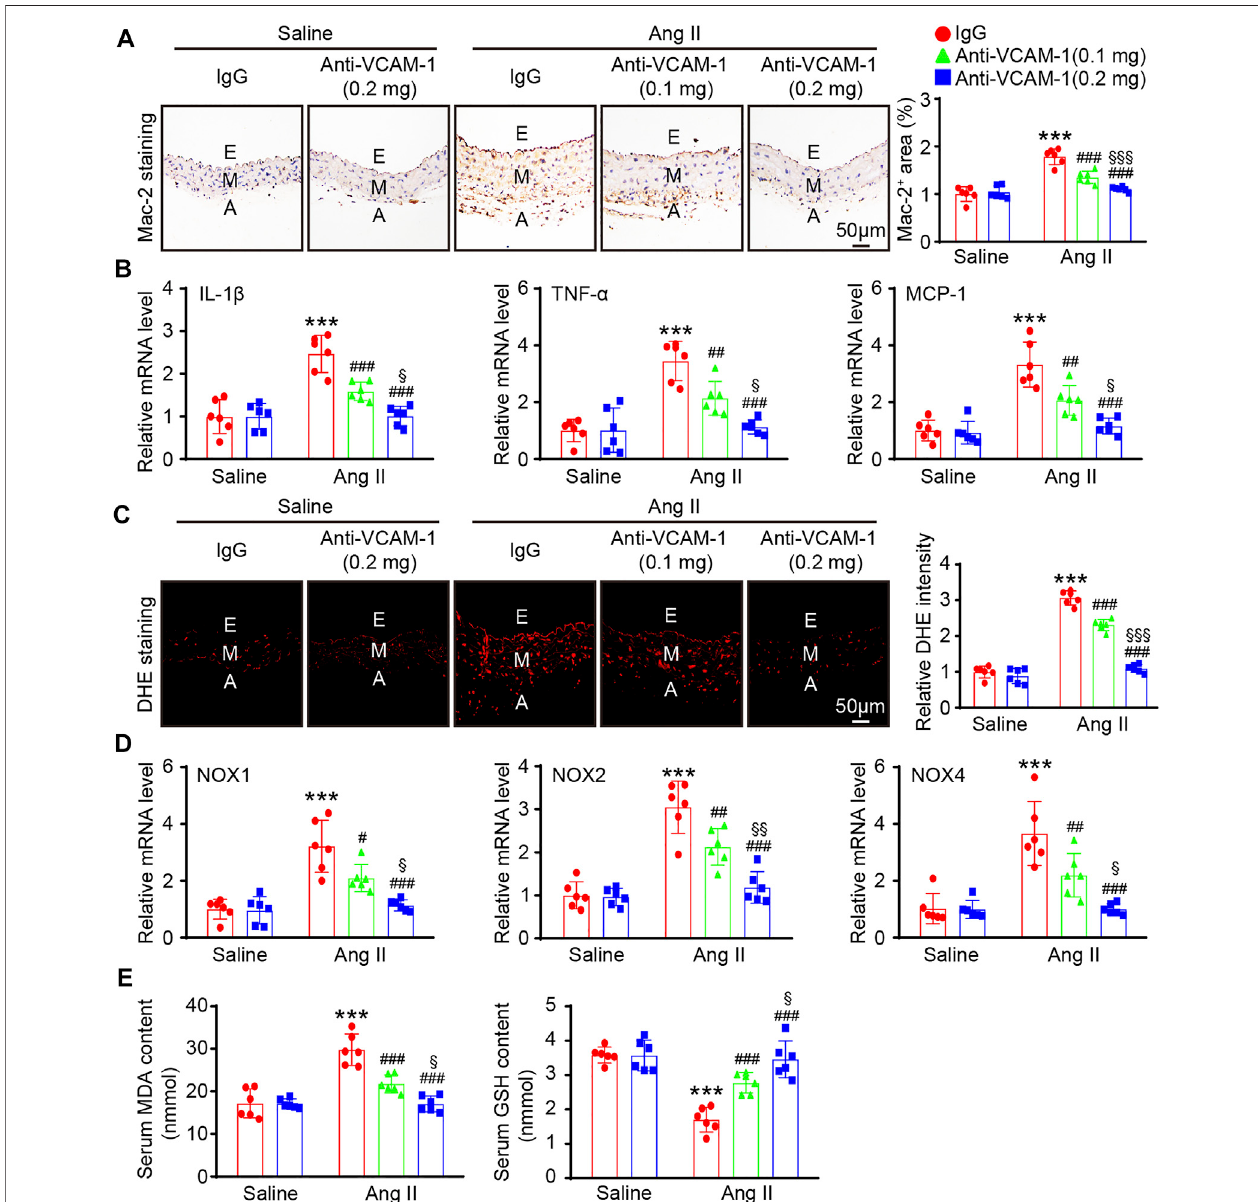
FIGURE 3 | Blockade of VCAM-1 inhibits Ang II-induced macrophage in fi ltration, in fl ammation, and oxidative stress. (A) WT mice were treated with a VCAM-1 neutralizing antibody (0.1 or 0.2 mg/mouse) or IgG control and infused with Ang II (490 ng kg − 1 min − 1 ) or saline for 14 days. Immunohistochemical staining of the aorta with a Mac-2 antibody (left, scale bar = 50 μ m) and analysis of the Mac-2-positive area (right, n = 6). (B) qPCR analysis of IL-1 β , TNF- α and MCP-1 mRNA levels in the aorta ( n = 6). (C) DHE staining of the aorta (left, scale bar = 50 μ m) and quanti fi cation of the relative fl uorescence intensity (right, n = 6). (D) qPCR analysis of the NOX1,NOX2and NOX4 mRNAlevels intheaorta ( n =6). (E) AnalysisoftheMDA concentrationand GSH levels inthesera ofmice from each group ( n = 6).The dataare expressed asthemean±SD,and nrepresentsthenumber ofsamples.** p < 0.01and *** p < 0.001versussaline; # p < 0.05, ## p < 0.01and ### p < 0.001versusAngII+ IgG; § p < 0.05, §§ p < 0.01 and §§§ p < 0.001 versus Ang II + anti-VCAM-1 (0.1